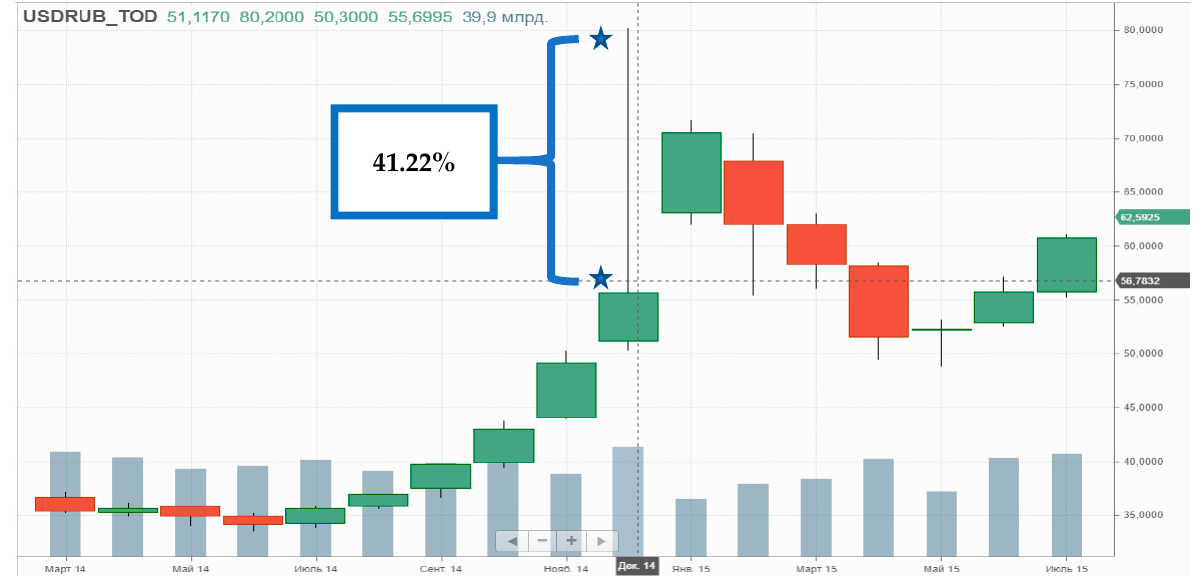
Figure 4. Actual TODAY quotes USD/RUR (USDRUB_TOD, Japanese Candlesticks, March 2014–July 2015, FINAM News Agency, monthly data [44]) and evaluating the short-term contribution of the function k ( 𝑡 ) in December 2014. The Russian words in the picture from left to right are: March, May, July, Sept., Nov., Dec., Jan., March, May, July. The Russian unit is hundred million.